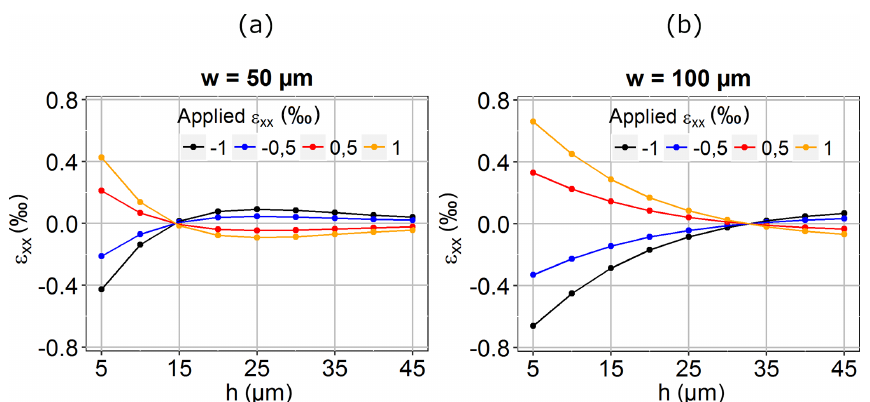
Figure 3. The graphs show the resulting transverse strain ( xx component) averaged over the top surface of the path and plotted vs. the path height for different applied strains. Panel (a) shows the results for a path width of 50µm, and panel (b) shows the results for a path width of 100µm.